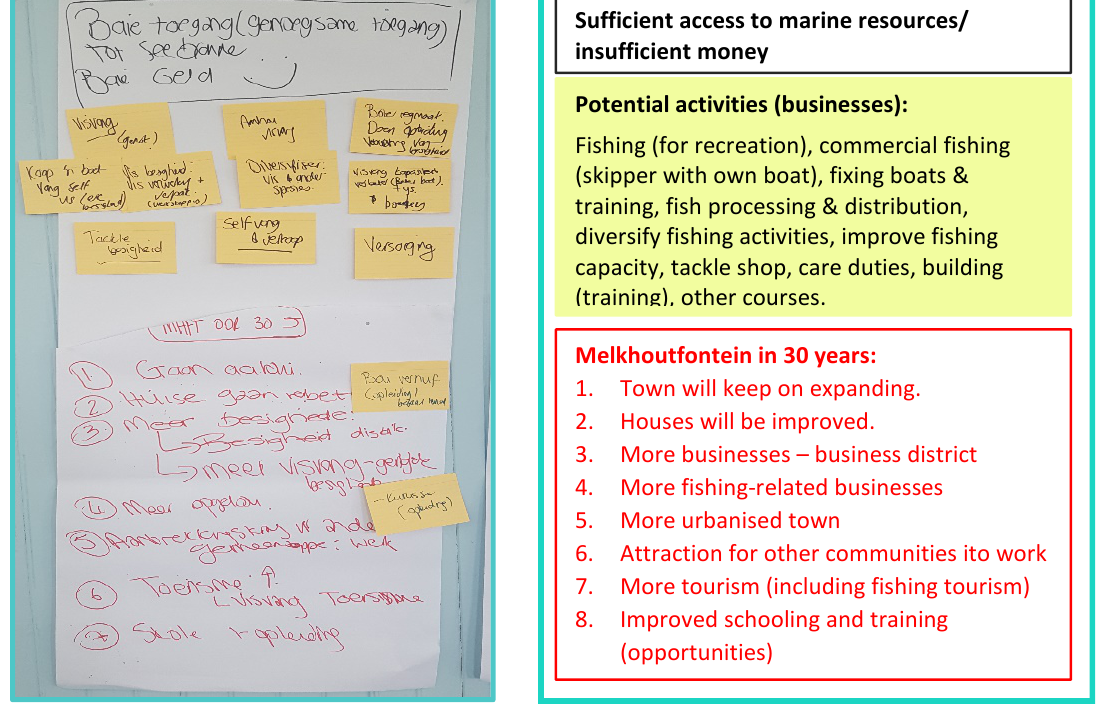
Figure A1.4. Elements of the “Sufficient access to Marine resources/Sufficient disposable income scenario” identified in workshop 3: yellow cards depict future livelihood activities that participants could engage in. The red text reflects the town in 30 years. The left panel shows a photograph of the results of the original story exercise in Afrikaans, whilst the right panel provides a